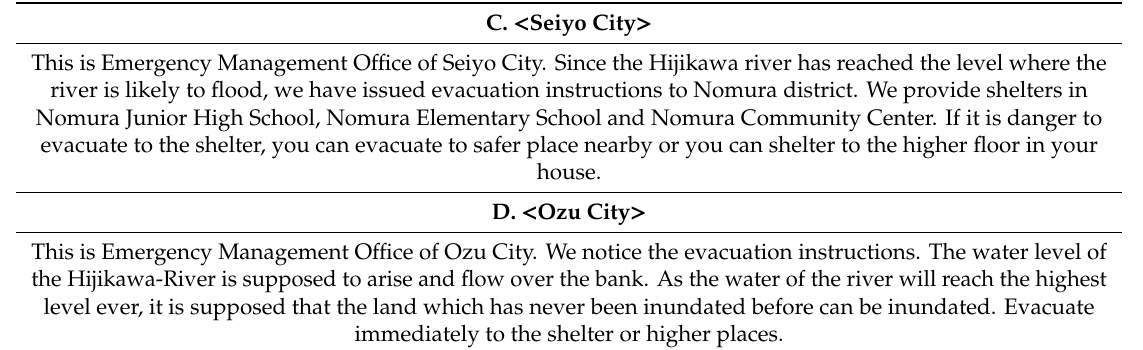
Table 3. Warning messages from local government (MLIT c